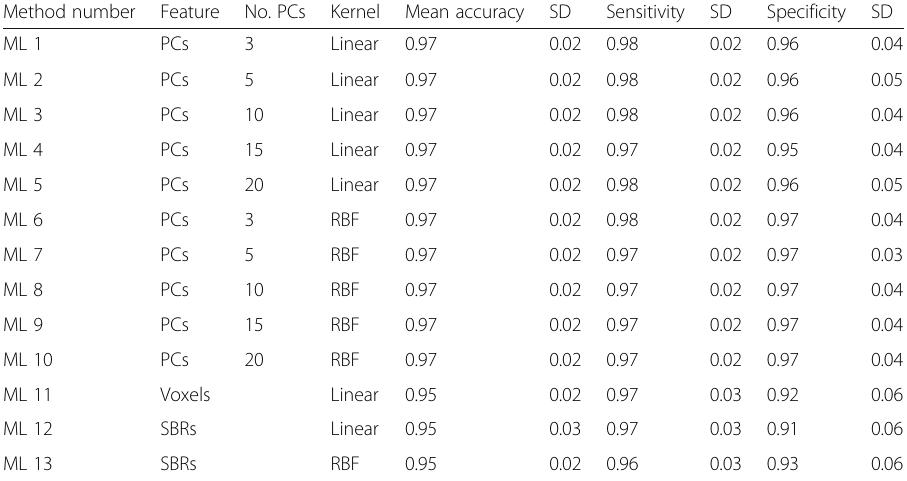
Table 7 Machine learning results for PPMI data